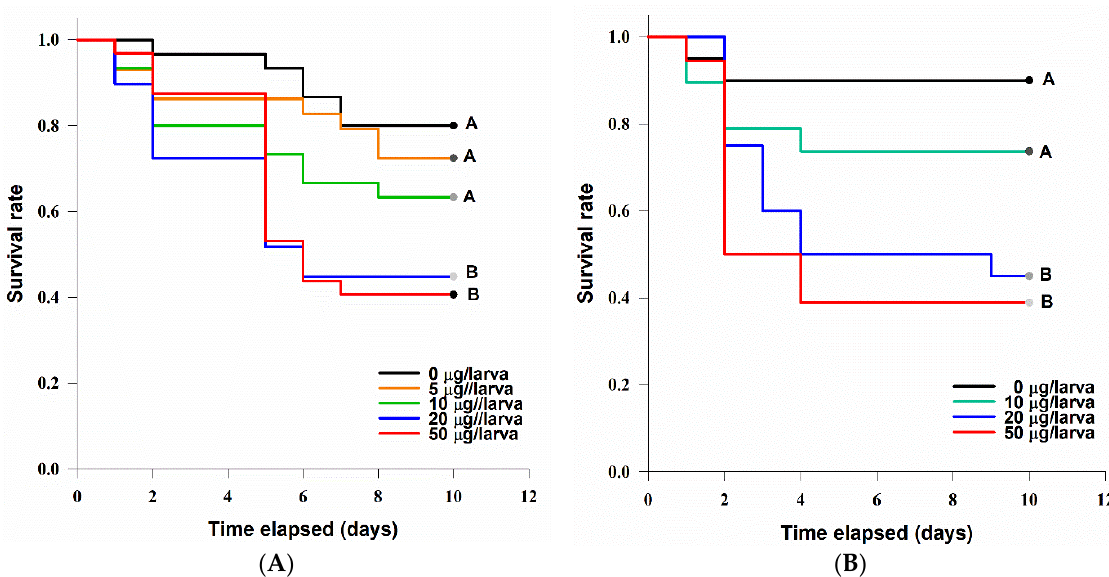
Figure 8. Survival curves of Galleria mellonella ( A ) and Zophobas morio ( B ) larvae after injection with various concentrations of tenuazonic acid. The curves marked with one letter did not differ significantly at p = 0.05 by log-rank test with Holm–Sidak adjustment.